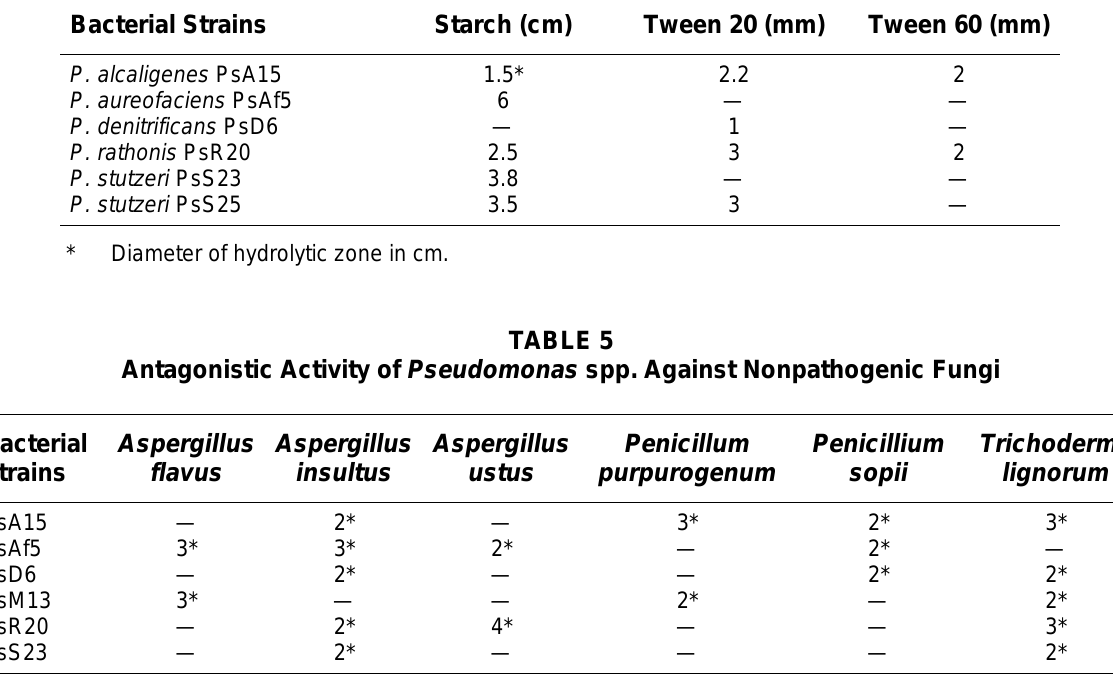
Activity of Pseudomonas spp. to Hydrolyze Starch and Tween in situ